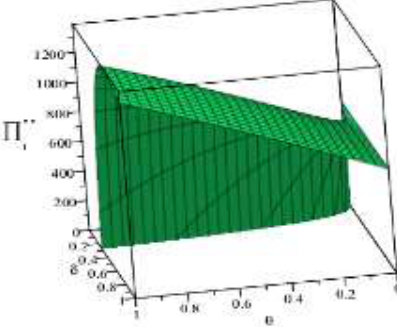
Figure 11. E ff ect of manufacturer behavior A on supply chain network under speculative Figure 11. Effect of manufacturer behavior A on supply chain network under speculative conditions.